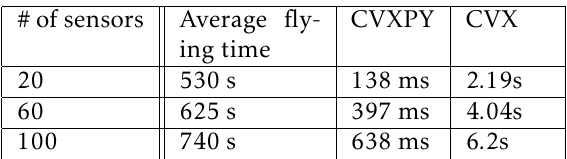
Table 1. The average executive time results in different tools for solving the problem